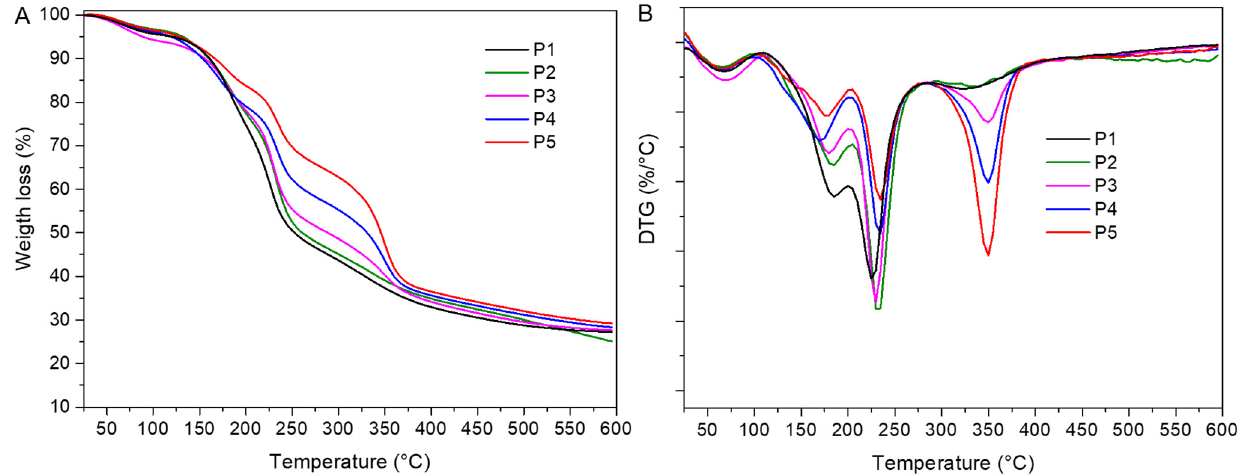
Figure 2. ( A ) TGA and ( B ) DTG diagrams of pectin-based films.